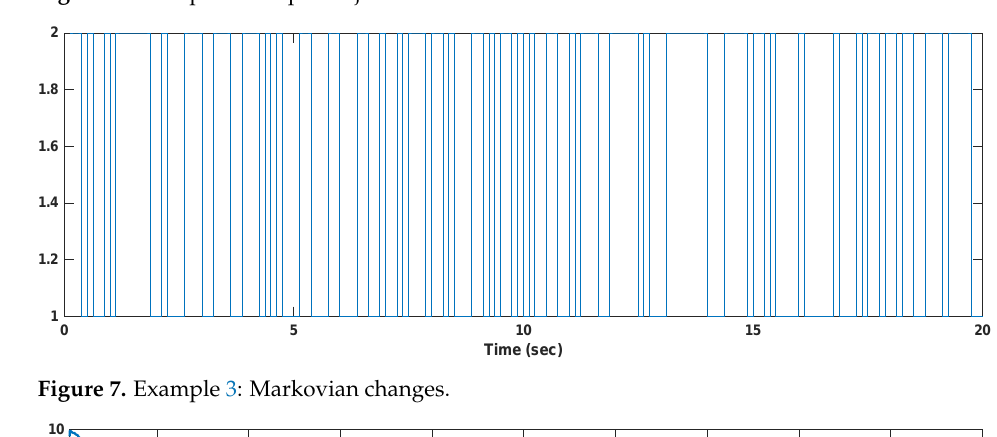
Figure 7. Example 3: Markovian changes.